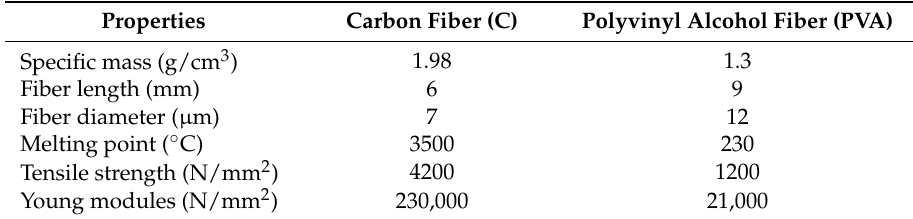
Table 2. The properties of the fiber used in the